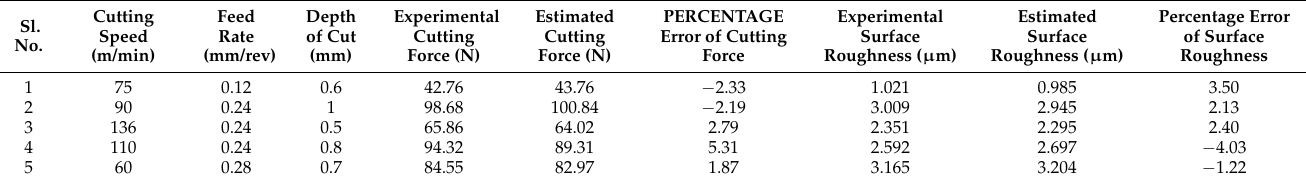
Table 7. Difference between the experimental and estimated values for cutting force and surface roughness, with percentage error calculations.